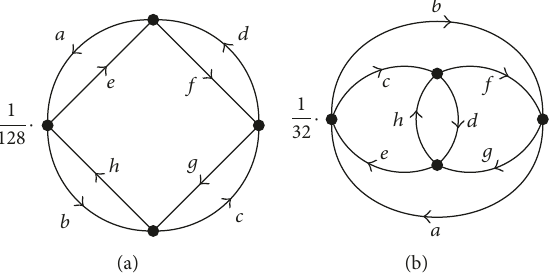
Figure 3: The first and second 2PI five-loop diagram (symmetry factors 1/128 (first) and 1/32 (second), 𝑅 = 1/72 = 0.0139 (first) and 𝑅 = 1/81 = 0.0123 (second)).